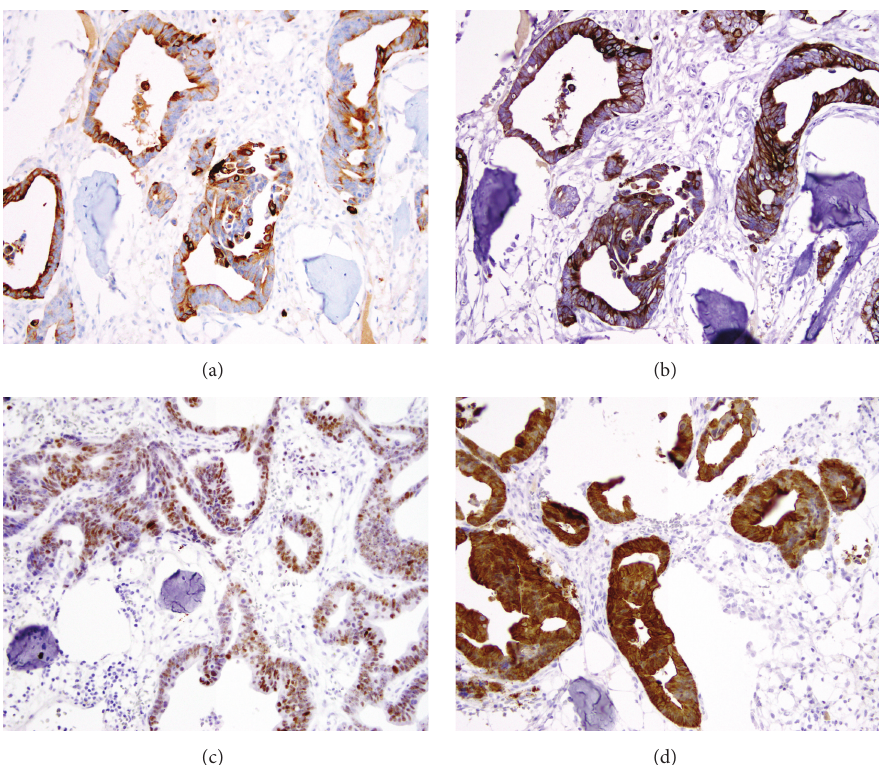
Figure 2: Case 1 immunohistochemical features of the soft tissue mass confirming metastatic focus of esophageal adenocarcinoma. The neoplastic glandular cells were diffusely and strongly positive for CK7 ((a) 200x), CK20 ((b) 200x), CDX-2 ((c) 200x), and Villin ((d)